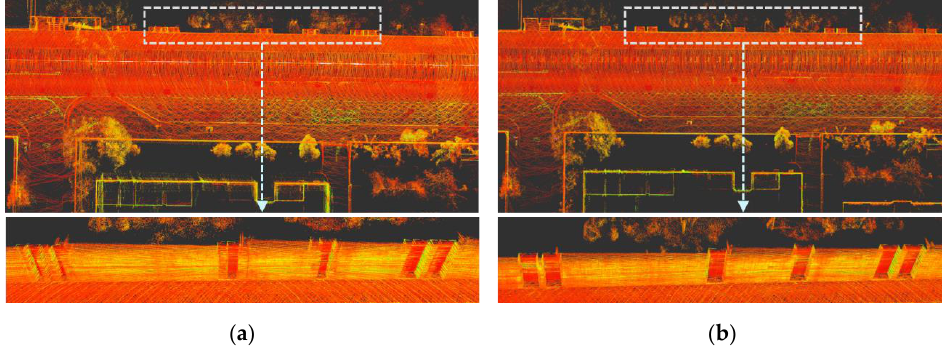
Figure 12. Comparison of the zoomed-in maps generated by LC-LIO-AC without and with the coarse-to-fine process around the third-place marked in Figure 11a where the vehicle passes by twice. The top panel and the bottom panel of both ( a , b ) are in the bird-eye view and approximately in the front view, respectively. ( a ) The map is generated without the coarse-to-fine process. When the vehicle passes the door the second time, a mismatch occurs between the point clouds registered in both times. ( b ) The map is generated with the coarse-to-fine process. The point clouds registered at the first time and the second time overlap. The map is more clear.